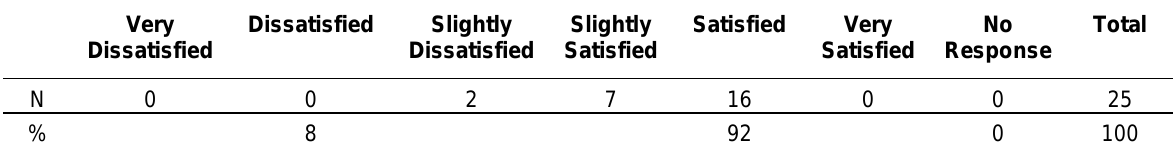
Workers’ Perceptions of the Responses of the Students to the Secondary 2 Curriculum